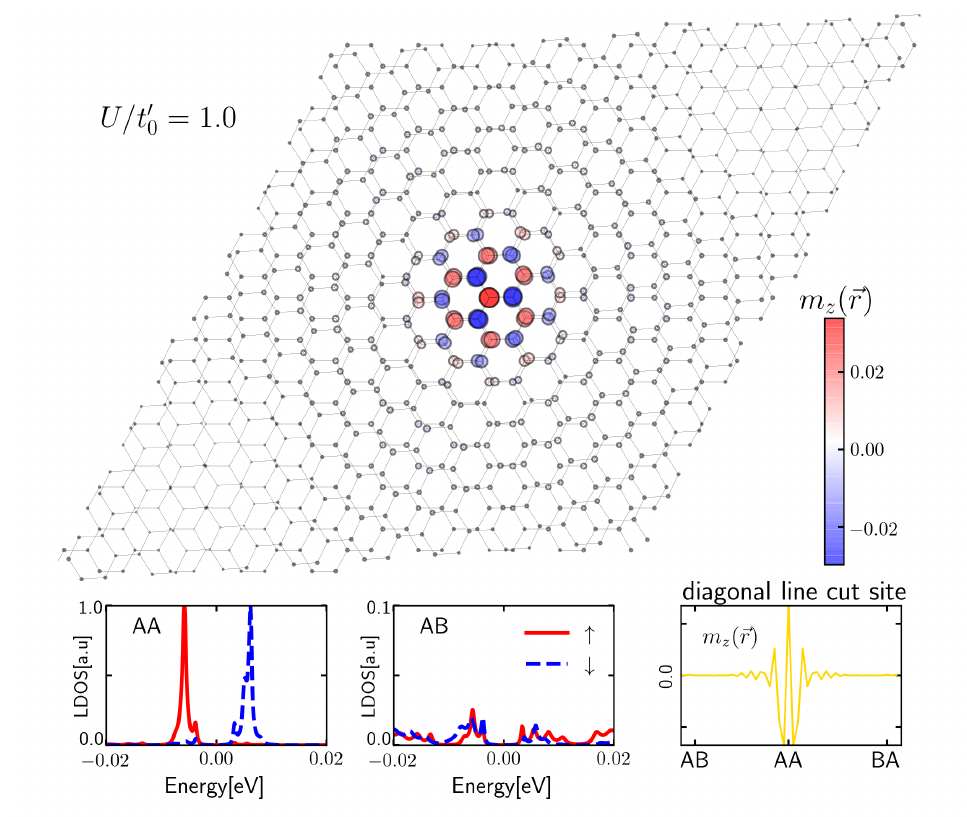
Figure 3: Top panel: MFT result for the spatial magnetization profile of a rescaled = 1.08 ◦ , and the on-site Coulomb interaction U / t (cid:48) twisted bilayer with θ eff bottom panels show the local density of states (LDOS) in the AA and AB regions for both spin projections (left two panels), and a diagonal line cut of the local magnetic moment (right